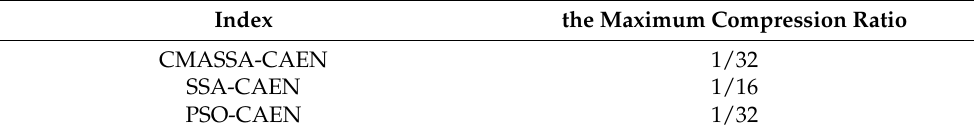
Table 8. The maximum compression ratio of the optimization algorithm on the MWD.